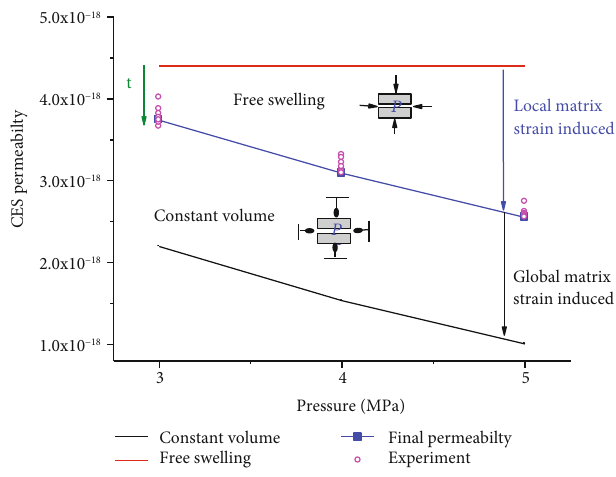
Figure 17: Comparison between the observed coal permeability change in the lab and the theoretical solution, both of which are bounded by free swelling and constant volumetric models (the di ff erential pressure between the con fi ning pressure and the injection gas pressure remains at 2